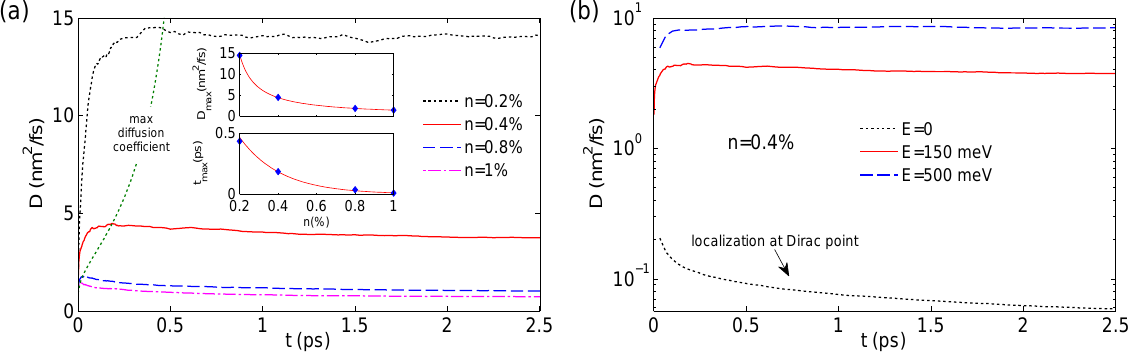
Figure 6b focuses on the case n = 0.4%. At energies far from the Dirac point, the decay of the diffusion coefficient is very slow, indicating that the system is in the diffusive transport regime. Close to the Dirac point, on the contrary, the behaviour is very